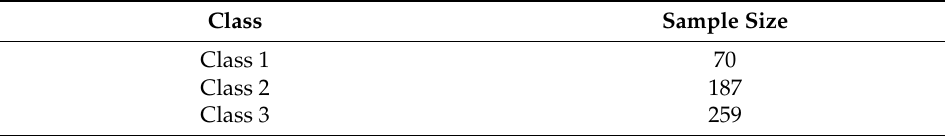
Table 2. Samples used for banana grade